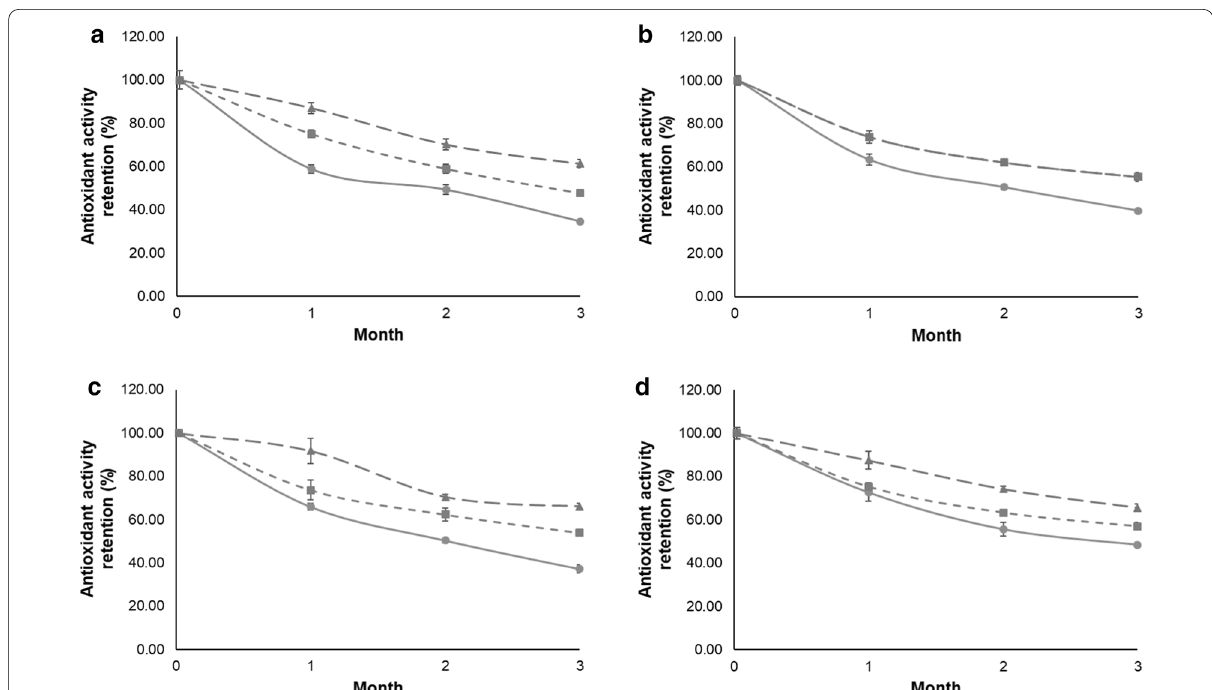
Fig. 4 Antioxidant activities of mamey and carrot microcapsules stored at different temperature and light conditions. “Filled tritangle” (4 °C without access to daylight); “Filled rectangle” (25 °C without access to daylight); “Filled circle” (25 °C in daylight). a M AG 5; b M AG 10; c C AG 5; d C AG 10. The data shown correspond to means